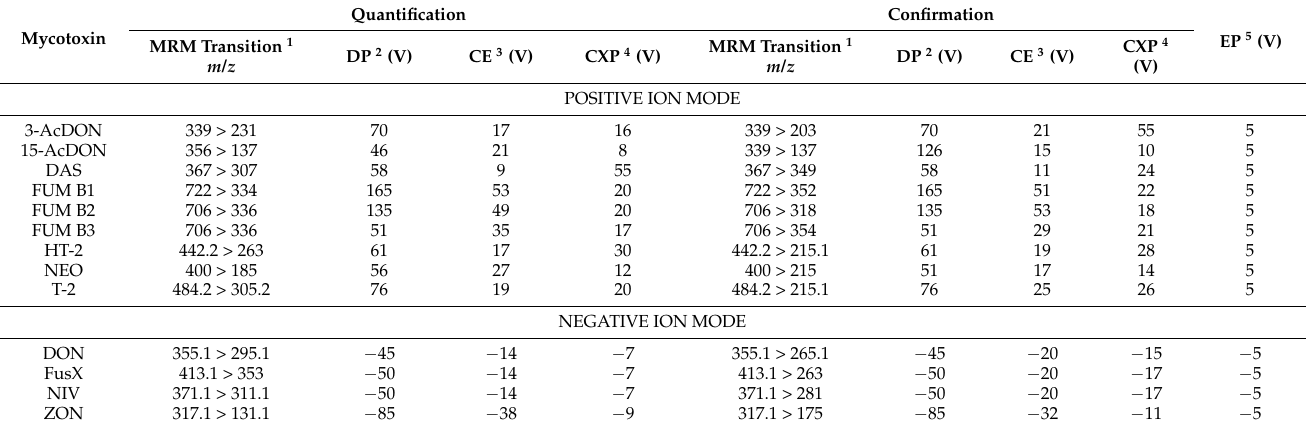
Table A1. LC–MS/MS parameters for the determination of mycotoxin in